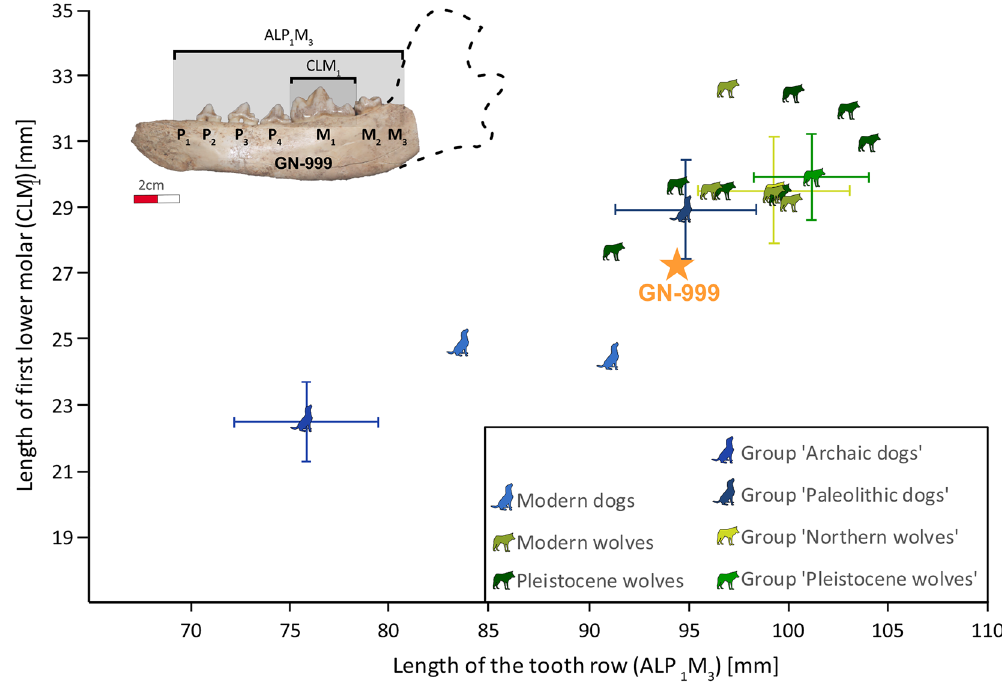
Figure 2. Metric data of GN-999 (black star) in comparison to metric data of seven canid groups (see Table S2): Modern dogs (n = 2, reference collection Uni Tübingen); Modern wolves (n = 4, reference collection Uni Tübingen and Bonn); Pleistocene wolves (n = 7, Brillenhöhle, Kesslerloch, Geißenklösterle. The four groups ‘Archaic dogs’ (n = 27), ‘Palaeolithic dogs’ (n = 31), ‘Northern wolves’ (n = 35) and ‘Pleistocene wolves’ (n = 36) are defined by Germonpré and colleagues 35 and defined by mean value and standard